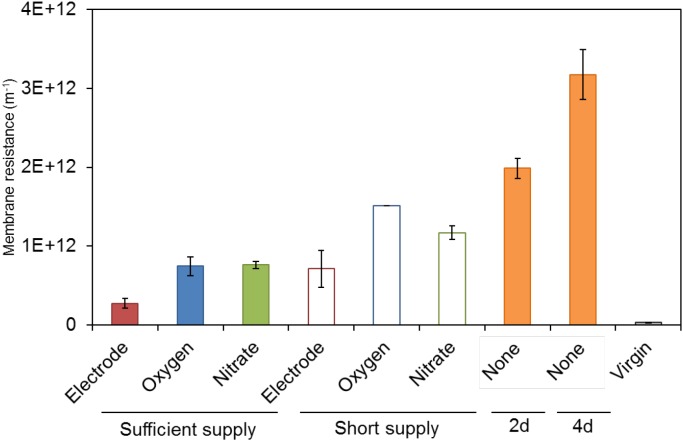
Fouling potential of strain S05 when cultured with different external electron acceptors. Statistical differences were estimated with P-value on the basis of two-sample t-test, which was summarized in Supplementary Table S1.